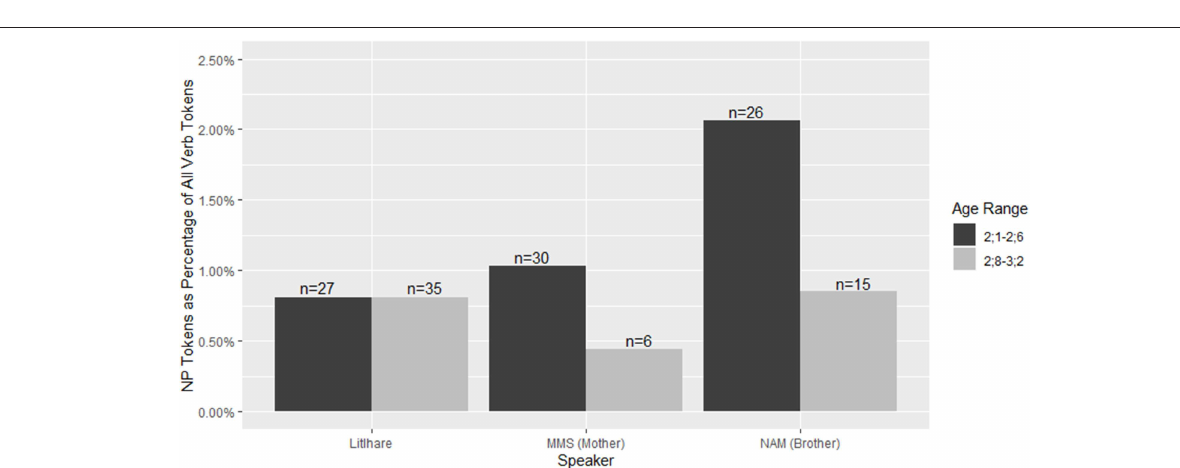
FIGURE 2 | Percentage of narrative past tokens of all verb tokens in the Litlhare sub-corpus.